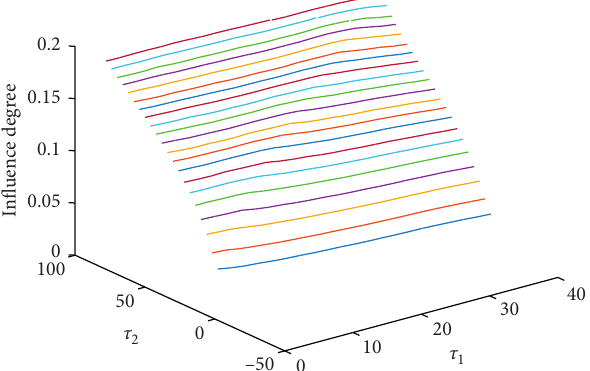
Figure 5: The time delay influence degree for delay τ SSEC and SZI and delay τ